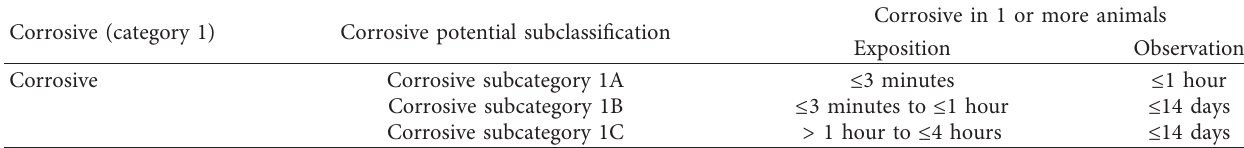
Table 1: Substance classification tested according to GHS/OECD parameters.